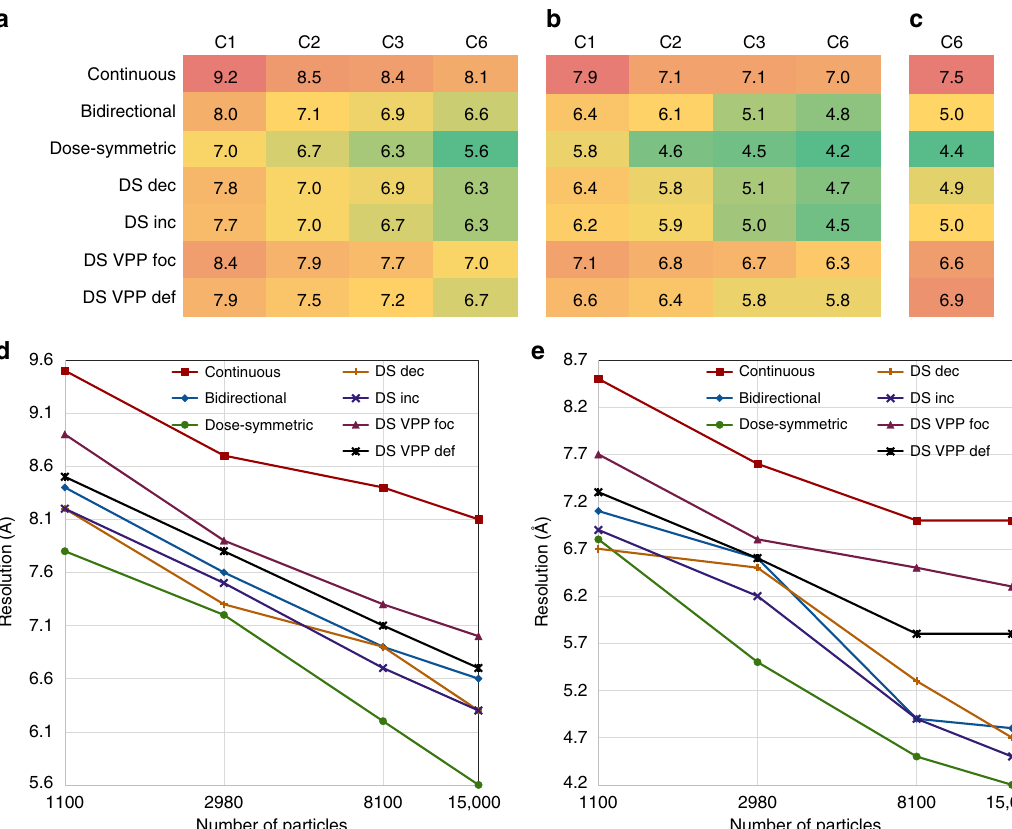
Fig. 2 Resolution estimates of structures obtained using different acquisitions schemes. a Resolution between the half maps with different symmetries obtained by FSC at 0.5 criterion. b Same as a , but the resolution was estimated using the 0.143 criterion. c Resolution estimate by FSC (0.5 criterion) between the EMD-3782 map and the respective maps with C6 symmetry applied. The respective FSC curves are shown in Supplementary Fig. 1. d B-factor analysis. Plot of resolution of C6-symmetrized structures at 0.5 criterion as a function of number of particles ( x -axis scaled logarithmically). e Same as d , but the resolution was estimated at 0.143